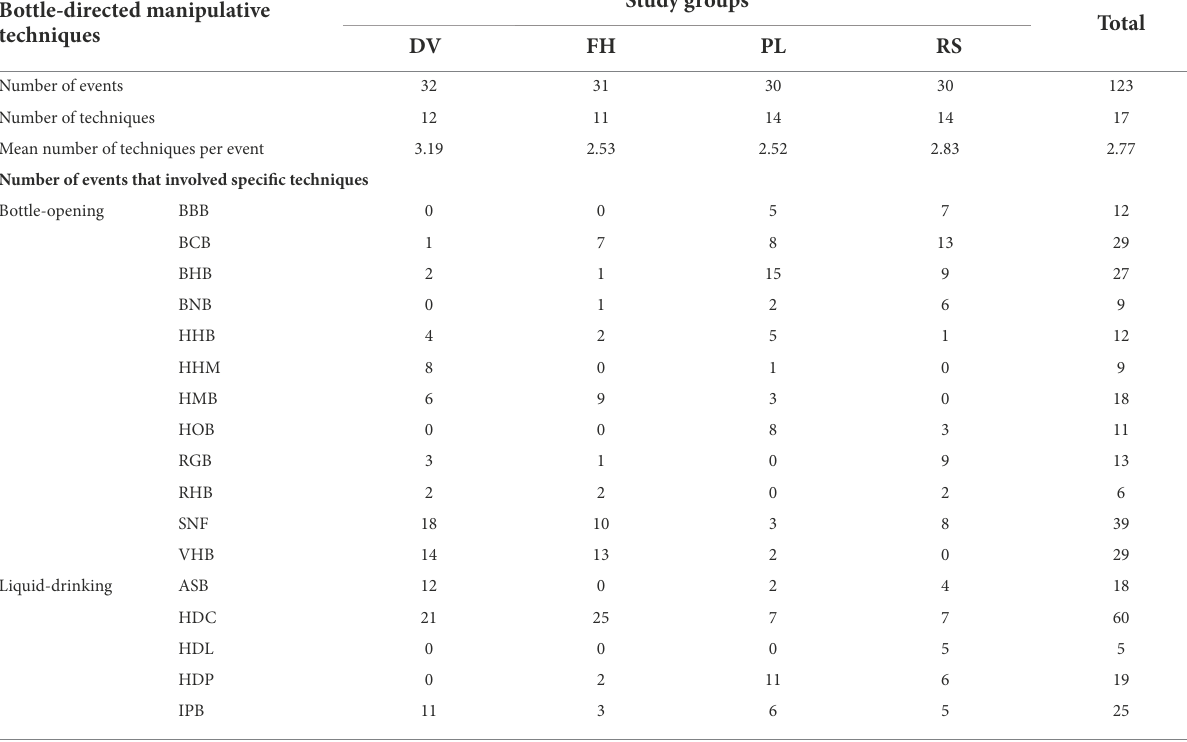
TABLE 4 Distribution of bottle-directed manipulative techniques and events across the four study bonnet macaque groups in Task I. Bottle-directed manipulative